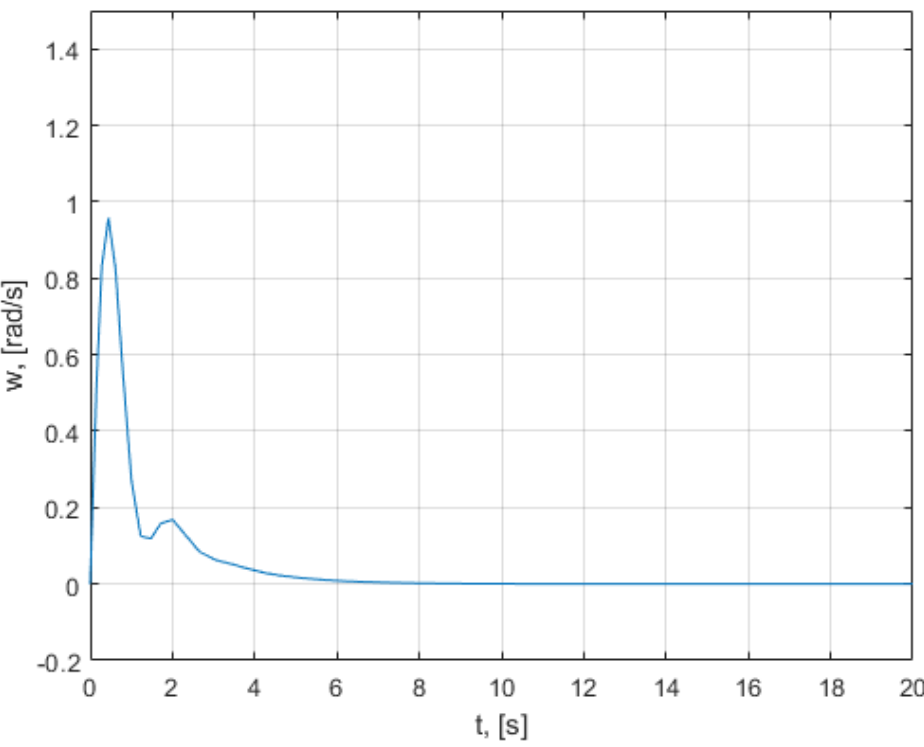
Figure A4. The speed response of position control system.